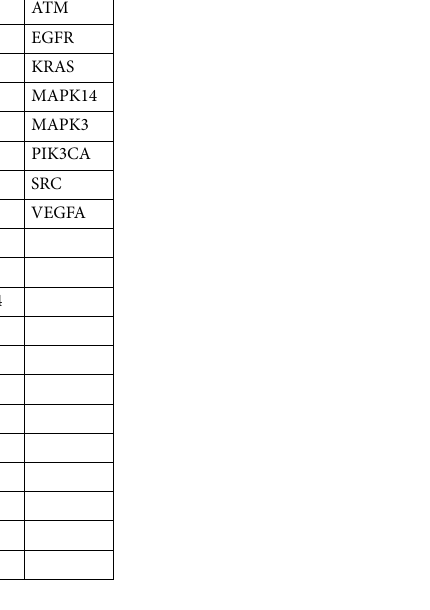
Table 1. The top 20 hub genes rank in